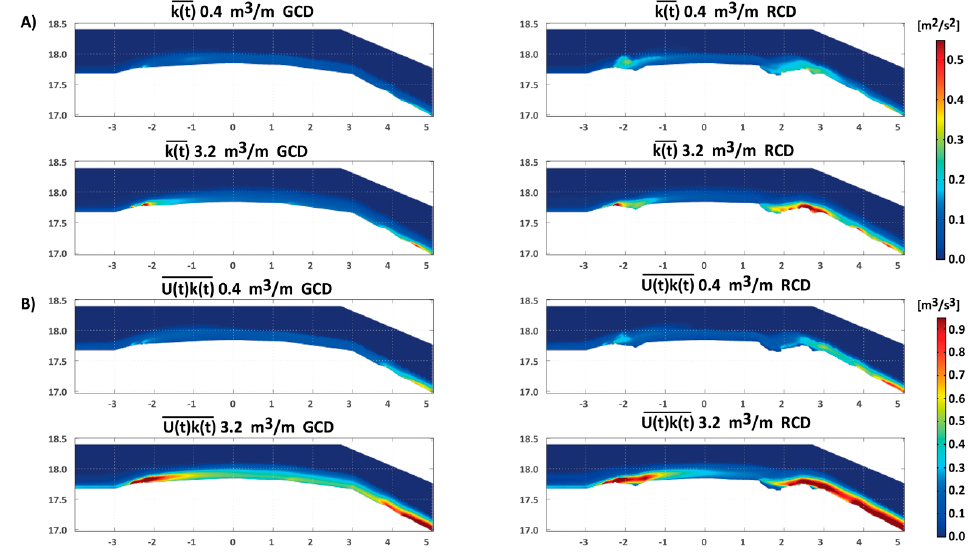
Figure 9. ( A ) Average kinetic energy ( k ( t ) ) of single wave volumes of 0.4 m 3 /m and 3.2 m 3 /m and ( B ) average turbulent erosive potential ( U ( t ) k ( t ) ) for single wave volumes of 0.4 m 3 /m and 3.2 m 3